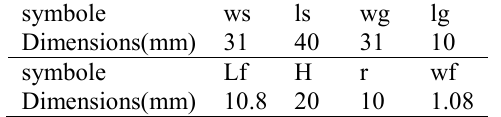
Table 1: Dimension of regular hexagonal antenna